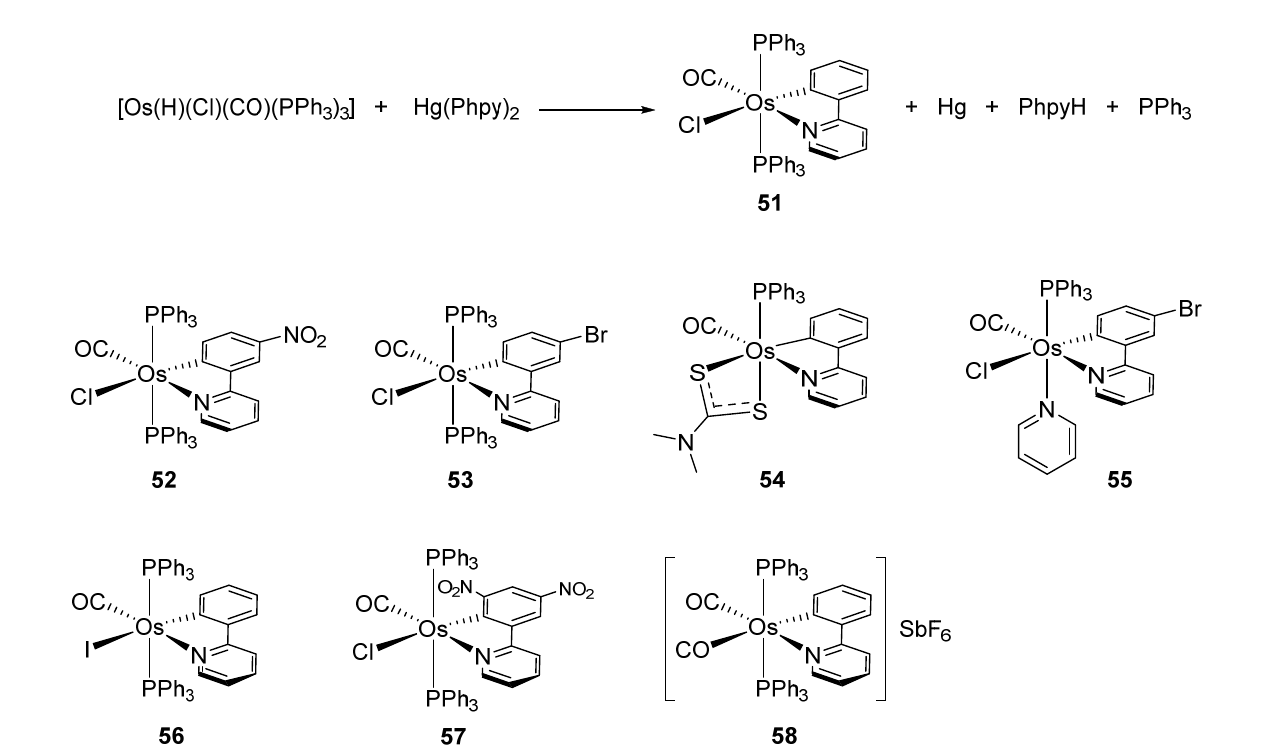
Figure 13. Osmium(II) complexes with cyclometalated phenylpyridines. Bennett et al.